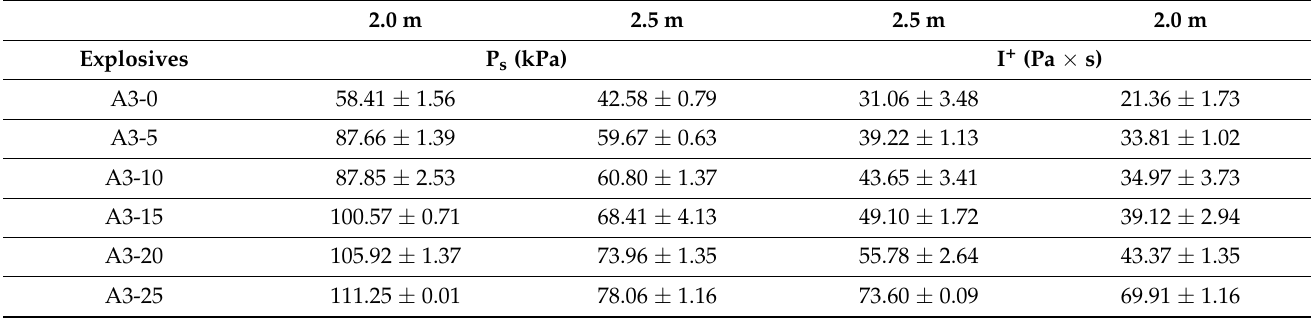
Table 3. Results of the measurements of blast wave characteristics for ammonals with 7% Al f .